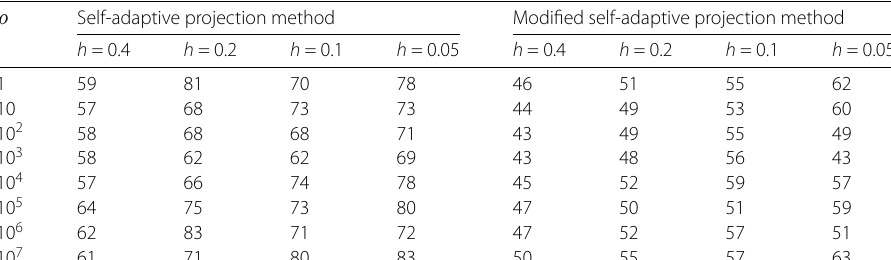
Table 1 Number of iterations for each method